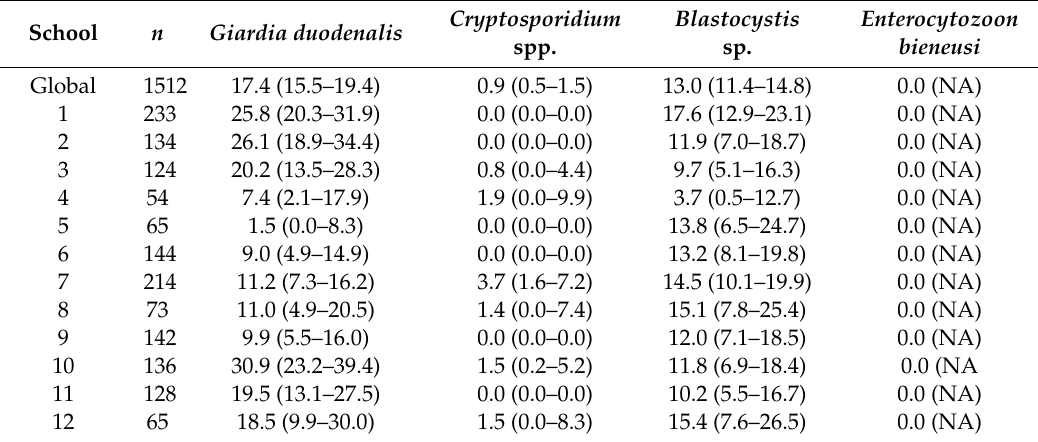
Table 1. Prevalence (%) and 95% confidence intervals (CIs) of the enteric parasite species investigated in the present survey according to school of origin, Legan é s, Madrid,